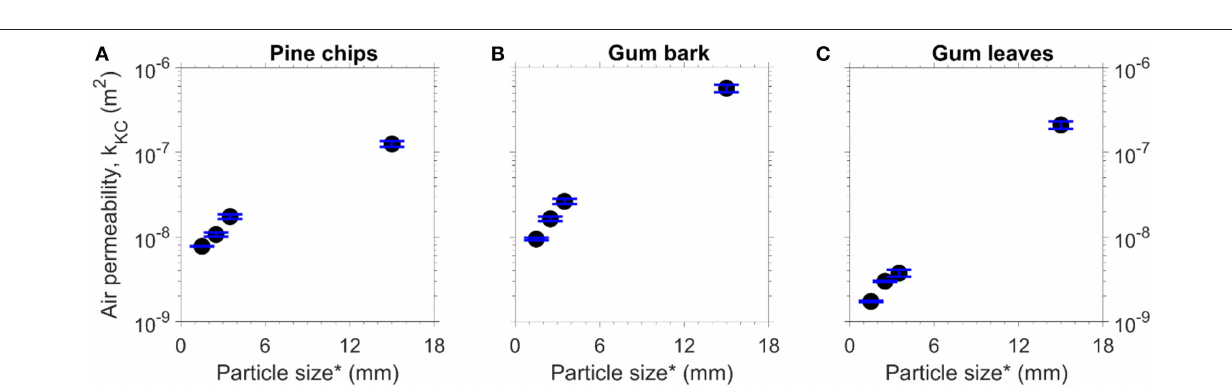
FIGURE 10 | Permeability (k) by K-C Equation as a function of particle size for the milled particles (*average sieve opening size) (A) pine chips, (B) gum bark, (C) gum